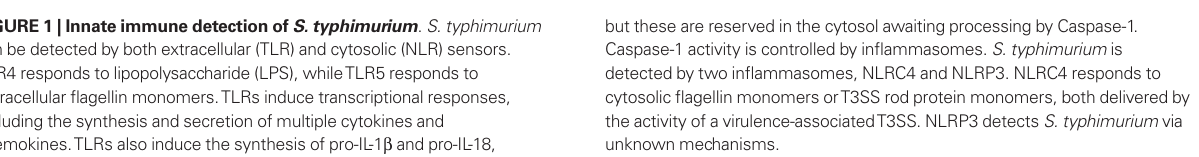
but these are reserved in the cytosol awaiting processing by Caspase-1. Caspase-1 activity is controlled by inflammasomes. S. typhimurium is detected by two inflammasomes, NLRC4 and NLRP3. NLRC4 responds to cytosolic flagellin monomers or T3SS rod protein monomers, both delivered by the activity of a virulence-associated T3SS. NLRP3 detects S. typhimurium via